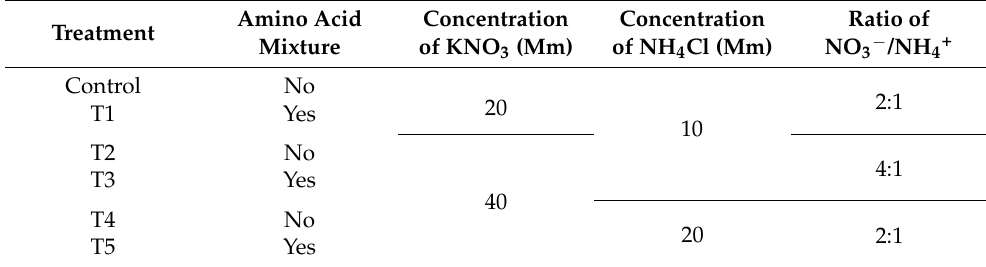
Table 4. The combinations of different nitrate and ammonium ion concentrations that were added to the Y3 medium, and with and without an amino acid mixture and applied to plumule tissues.